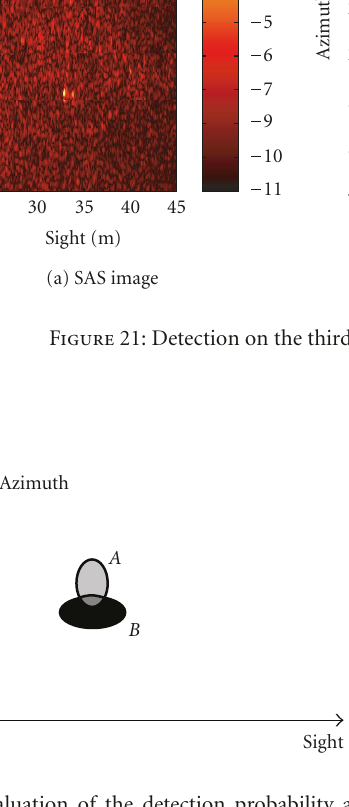
Figure 22: Evaluation of the detection probability and the false alarm rate: A is a region considered by the expert as a “real” echo, B is a region segmented at a given